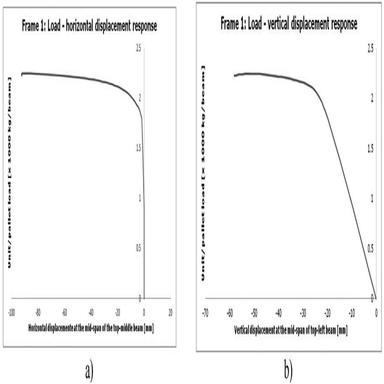
Load-displacement response of SR1: a) load-horizontal displacement and b) load-vertical displacement.